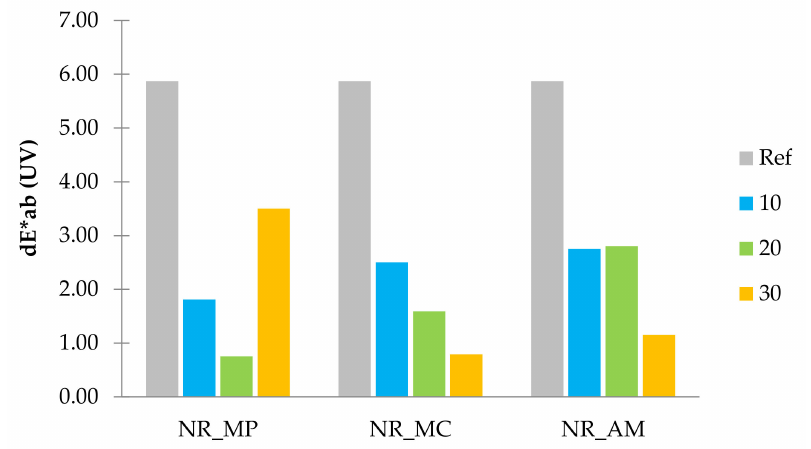
Figure 14. Parameters dE*ab after UV aging.